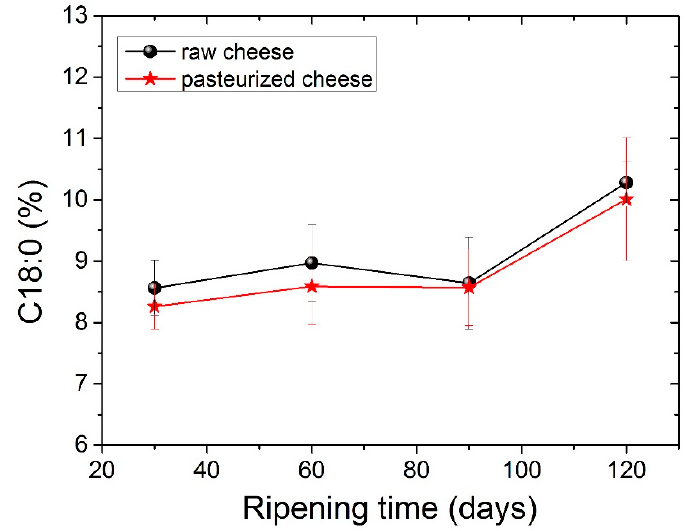
Figure 2. Stearic acid C18:0 values (%) for both types of cheese during ripening.